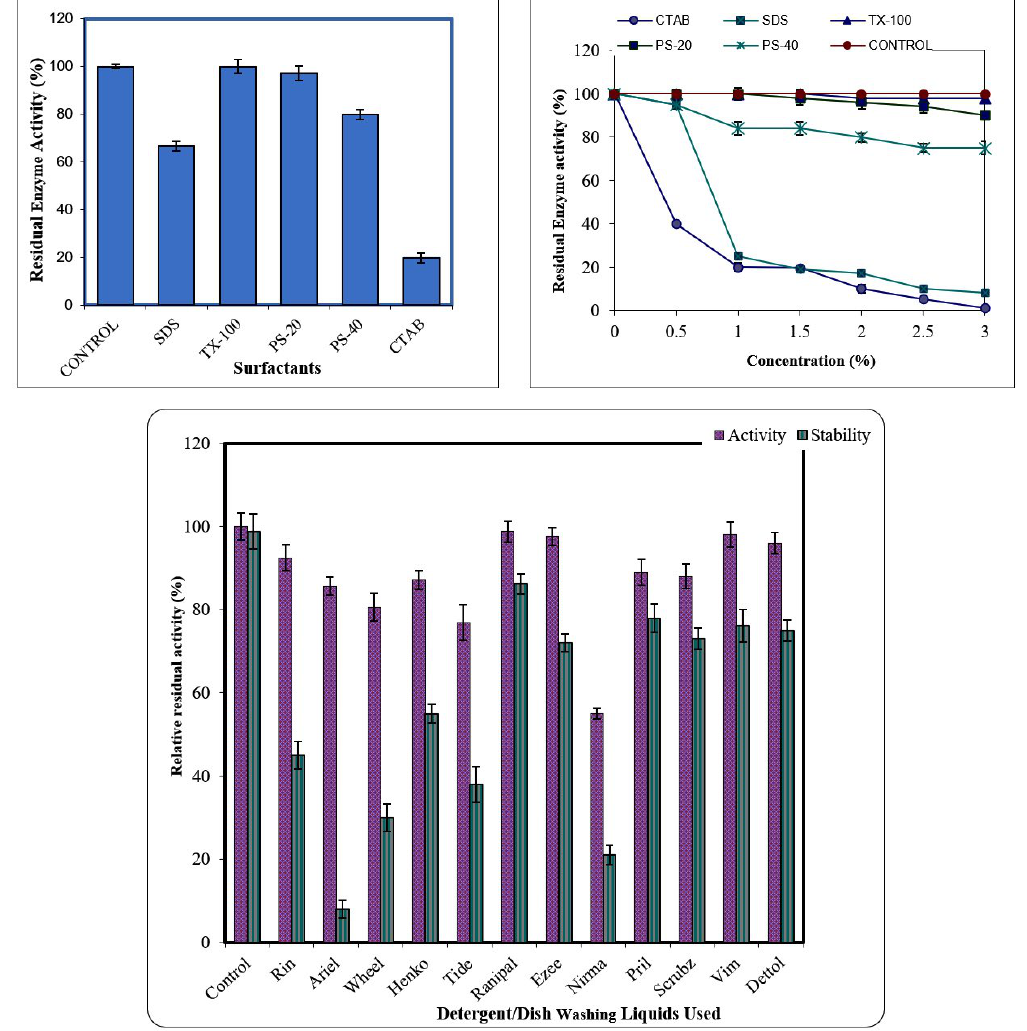
Fig. 5. (a) Effect of various surfactants on enzyme activity of purified β-mannanase from P. thiaminolyticus. (b) Effect of various surfactants on enzyme stability of purified β-mannanase from P. thiaminolyticus . The purified enzyme was incubated at 60°C for 1 h in the presence of different concentration of surfactants and the residual activity was determined. (c) Effect of various detergents/dish washing liquids on enzyme activity and stability of purified β-mannanase from P. thiaminolyticus. The purified enzyme was incubated at 60°C for 45 min in the presence of detergents/dishwashing liquids and enzyme stability (grey bars) was